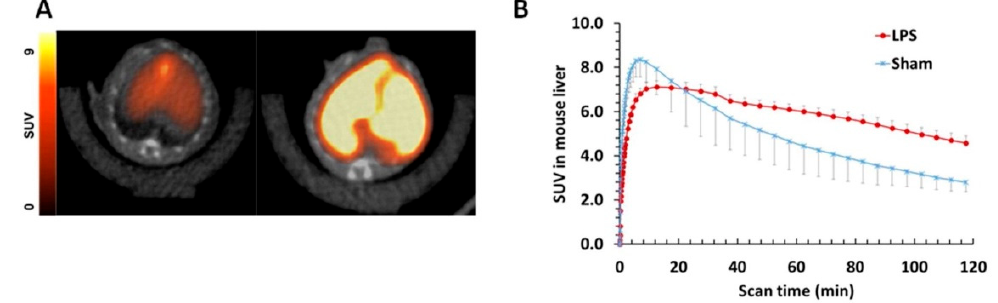
Figure 8. ( A ) Representative summed 120 min transverse PET/CT images of [ 18 F]-53 in a sham (left) and LPS-treated (right) mouse. ( B ) Liver time − activity curves (TAC) of [ 18 F]53 standardized uptake values (SUV) in sham and LPS-treated mice. Adapted with permission from A. J. Rosenberg et al. J.